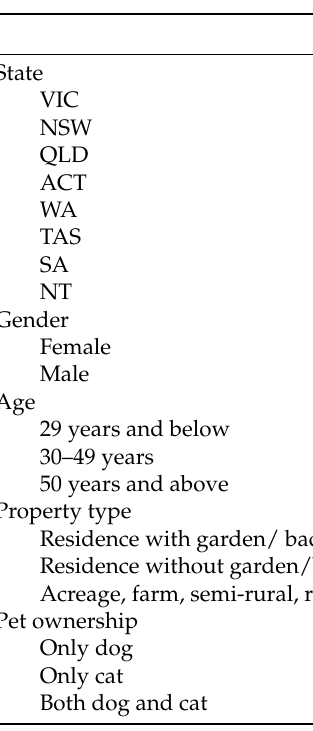
Table 1. Demographic characteristics of pet owners ( n =